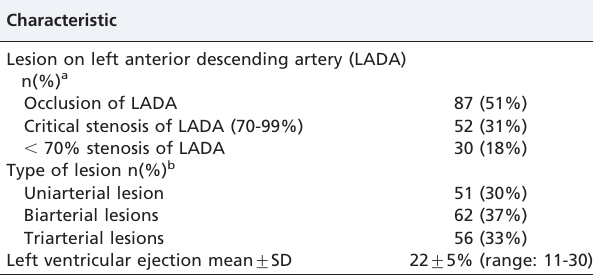
Table 2 - Baseline angiographic data of the study population (n=